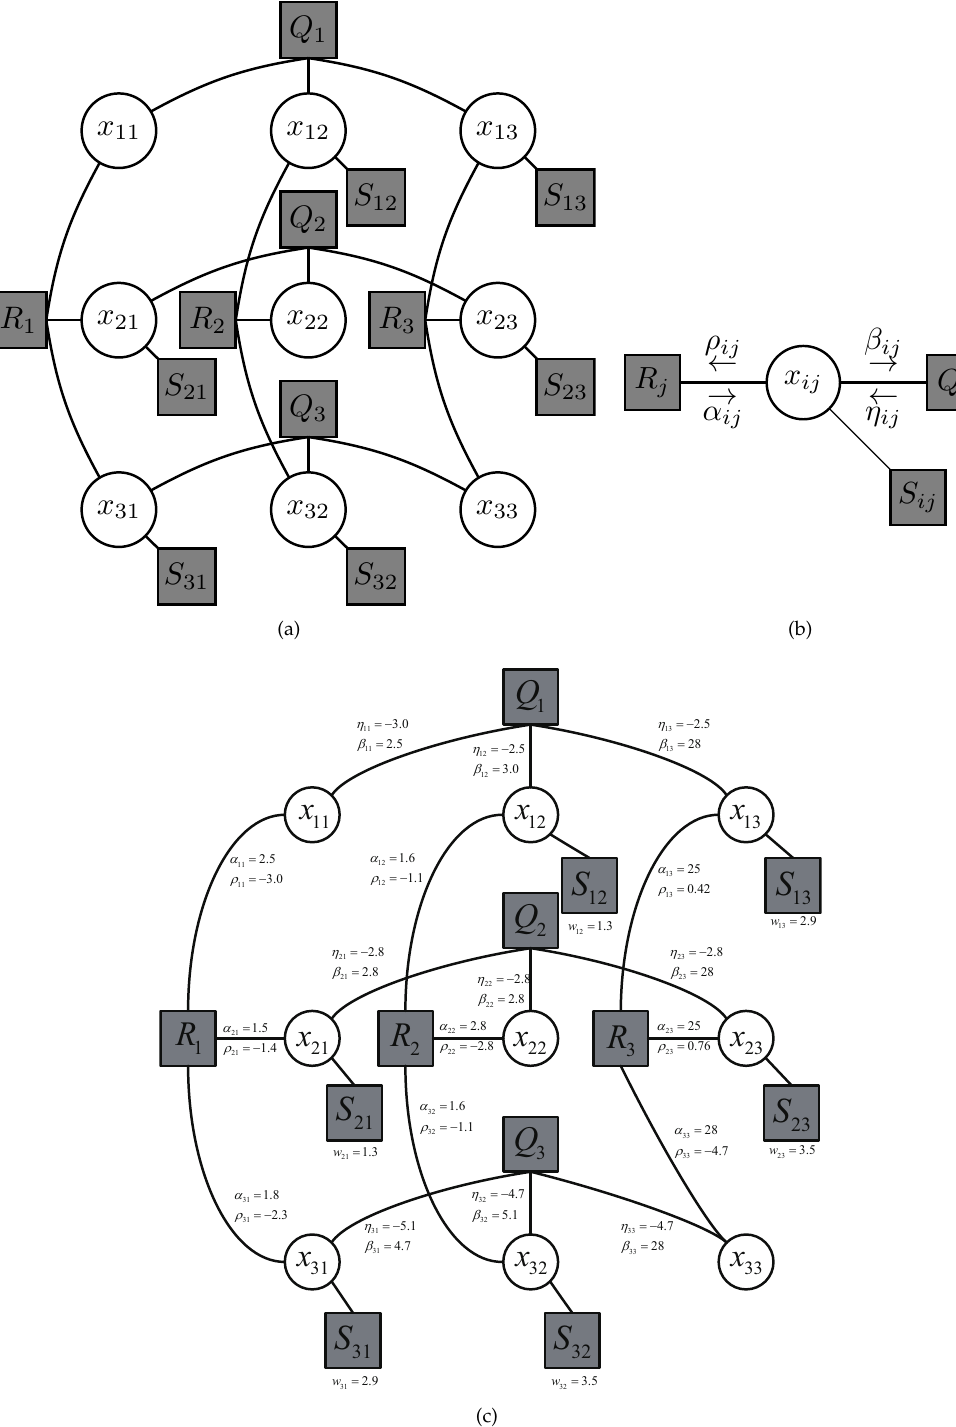
Figure 3. Graphical models. ( a ) Graphical model of 3-node WSN; ( b ) Message definition around a single variable; ( c ) Example of message-passing operation for 3-node